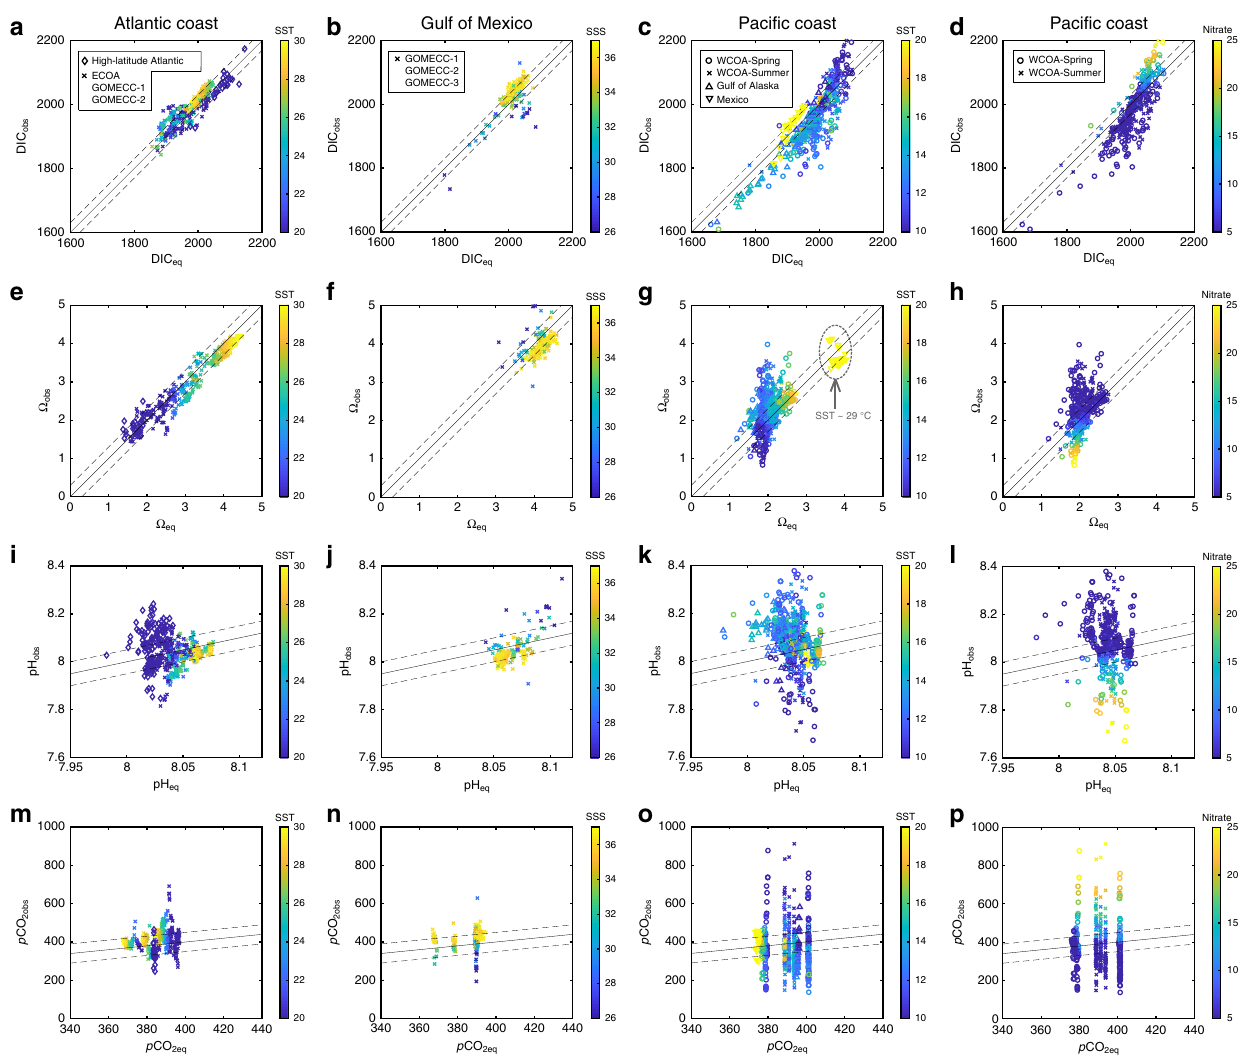
Fig. 5 Observations vs. calculated values. These values are at equilibrium with atmospheric CO 2 along North American margins. a – d are DIC, e – h are Ω – l are pH, m – p are p CO fi c Coast (columns 3 and 4). The Paci fi c Coast arag , i 2 in the Atlantic Coast (column 1), Gulf of Mexico (column 2), and Paci occupies two columns color coded by SST and Nitrate, respectively. DIC obs , Ω obs , pH obs , and p CO 2obs stand for the measured DIC and properties calculated from measured DIC and TA. DIC eq , Ω eq , pH eq , and p CO 2eq represent values calculated under the conditions of seawater equilibrium with atmospheric p CO 2 at the time of fi eld observation programs (see the “ Methods ” section). pH obs and pH eq are on the total proton concentration scale. The dashed lines around the 1:1 line are ±30 μ mol kg − 1 for DIC, ±0.3 for Ω , ±0.05 for pH, and ±50 μ atm for p CO 2